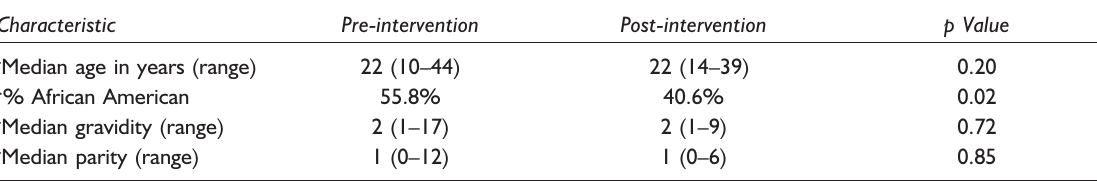
Characteristic Pre-intervention